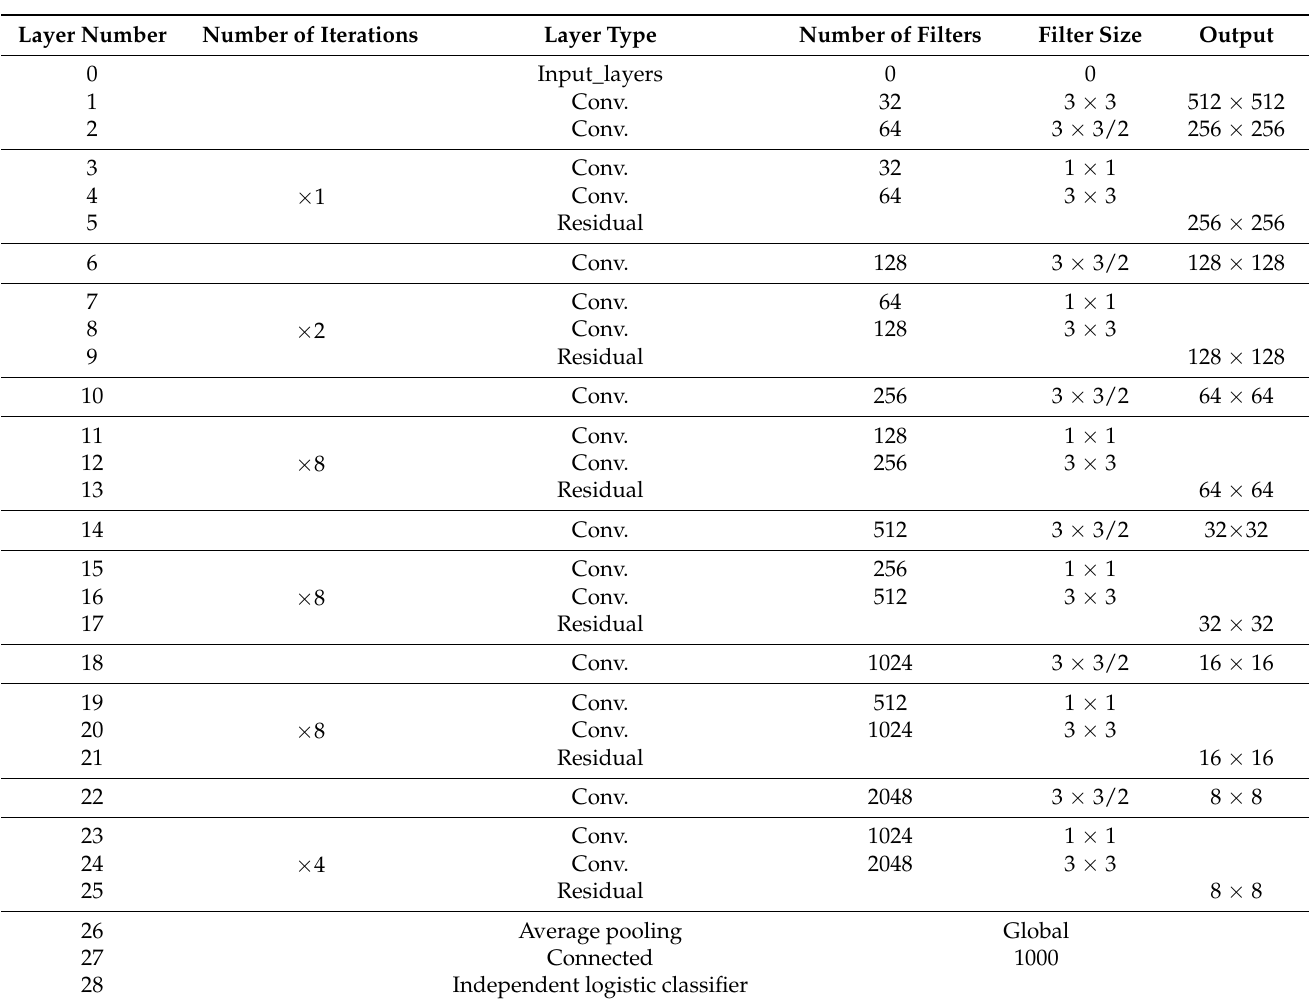
Table 2. Architecture of